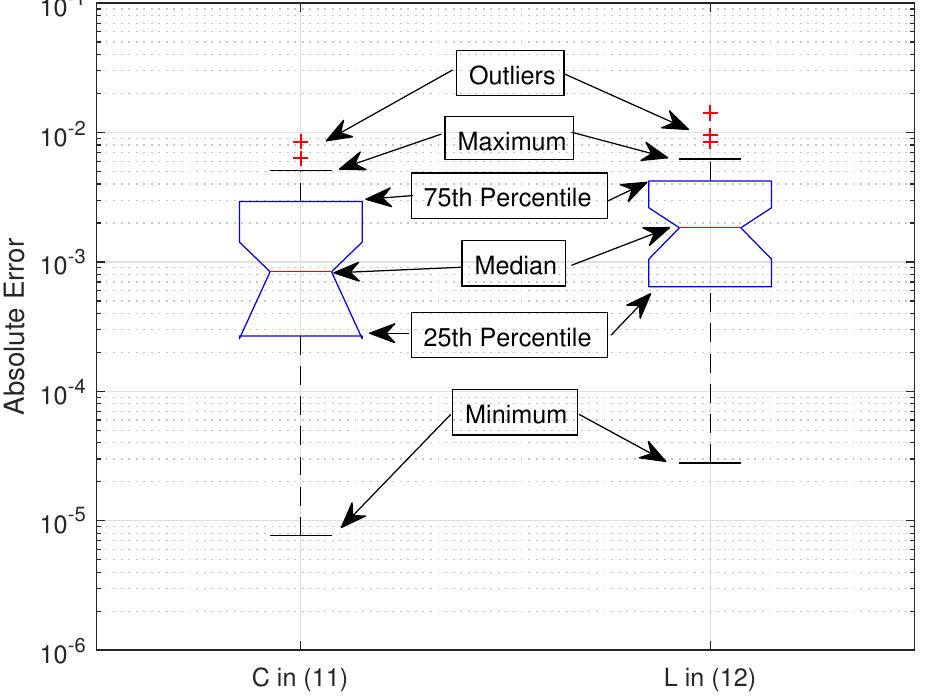
Figure 4. Summary statistics of absolute error between analytical and simulation results of the sum capacity and sum leakage rate. The outliers denoted by ‘+’ marker indicate the values which fall 1.5 times away from the top interquartile range of the box